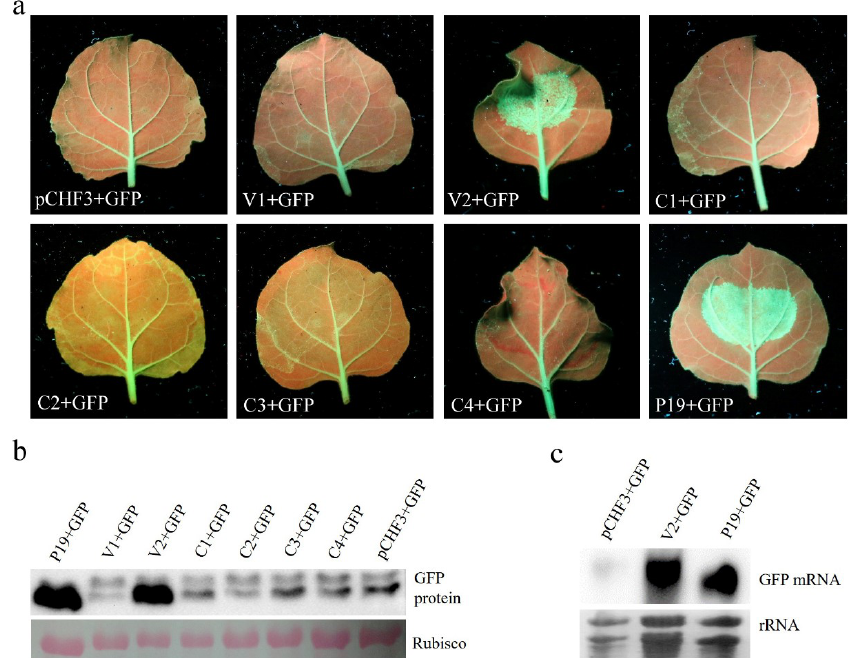
Figure 3. Suppression of local PTGS by AGV V2. (a) The leaves of GFP -transgenic 16c line were co-infiltrated with agrobacterium suspension harboring 35S-GFP expressing GFP and one of the recombinant vectors expressing AGV proteins as indicated below the images. The leaves expressing pCHF3 + GFP were used as negative control and leaves expressing P19 + GFP were used as positive control. The photographs were taken under UV light at 5 d post infiltration. ( b ) Western blot analysis of GFP accumulation in the co-infiltrated leaf patches at 5 d post infiltration. The Ponceau-stained rubisco indicates the equal loading of total proteins. ( c ) Northern blotting analysis of GFP mRNA accumulation from the co-infiltrated leaf patches at 5 d post infiltration. The rRNAs below indicate the equal loading of total RNAs.